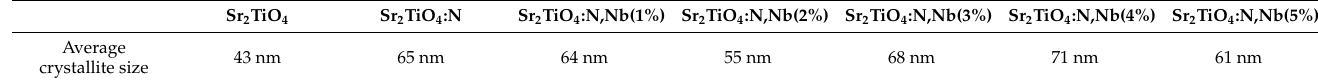
Table 2. Average crystallite size of Sr 2 TiO 4 , Sr 2 TiO 4 :N, and Sr 2 TiO 4 :N,Nb. Figure 2. TEM images of ( a ) Sr 2 TiO 4 ; ( b ) Sr 2 TiO 4 :N,Nb(2%). Sr 2 TiO 4 Sr 2 TiO 4 :N Figure 1. XRD patterns and partial enlarged view of Sr 2 TiO 4 , Sr 2 TiO 4 :N, and Sr 2 TiO 4 :N,Nb. The morphological characterization of Sr 2 TiO 4 and Sr 2 TiO 4 :N,Nb(2%) were shown in Figure 2. After being calcined at 1000 °C for 4 h, both pristine Sr 2 TiO 4 and Sr 2 TiO 4 :N,Nb(2%) were composed of irregular particles ranging from tens of nanometers to 1 micron.